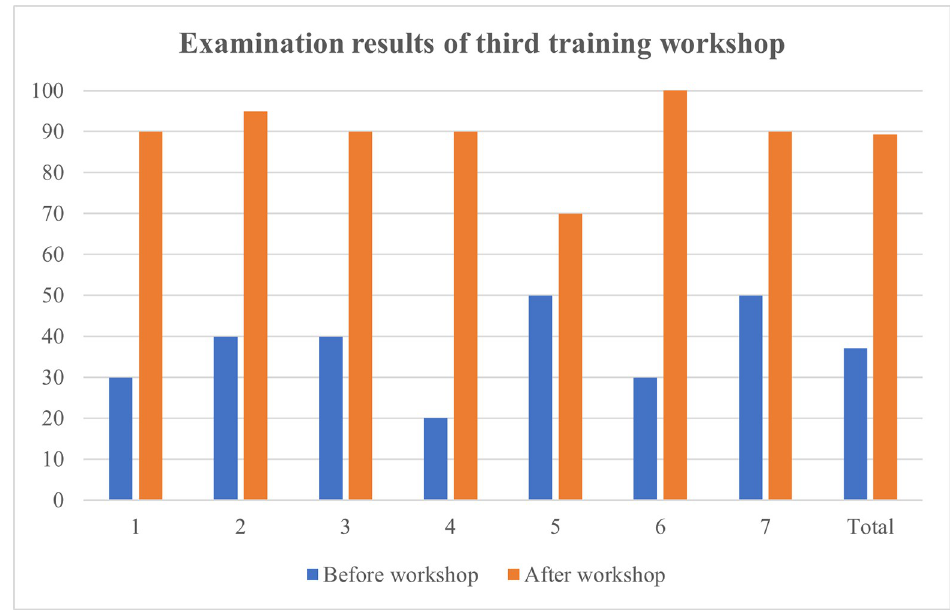
Fig 3. Comparison of participants’ knowledge assessment percentage results before and after the presentation of the third training workshop. 1 –participant 1; 2 –participant 2; 3 –participant 3; 4 –participant 4; 5 –participant 5; 6 – participant 6; 7 –participant